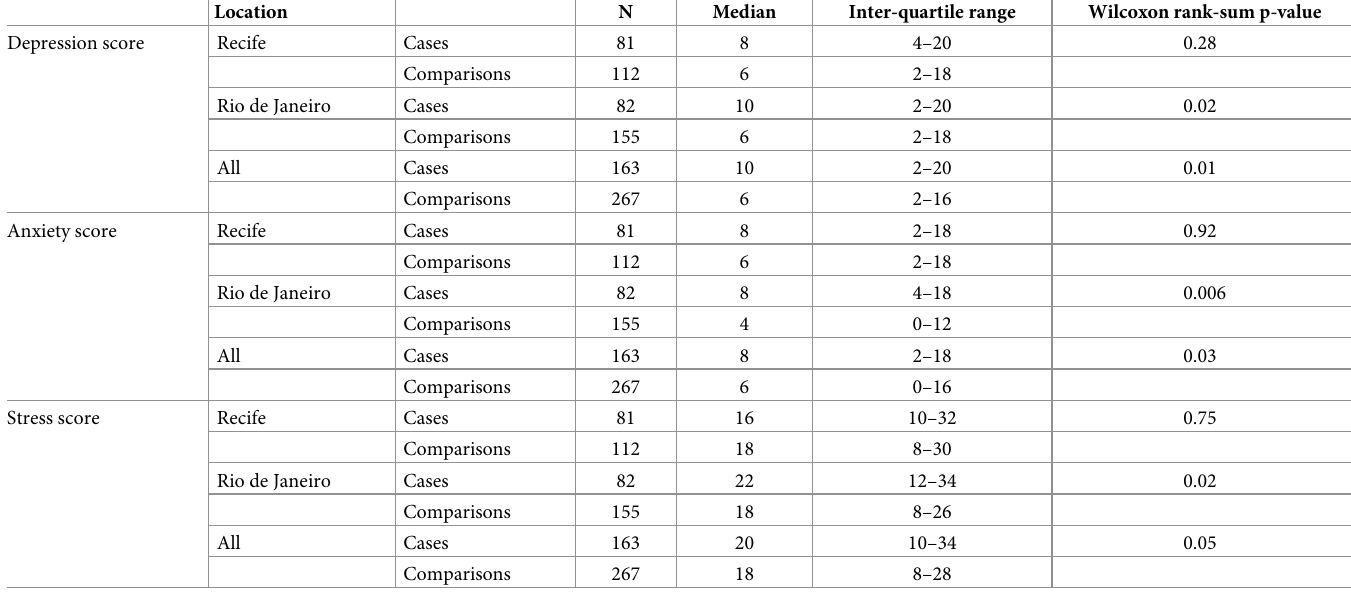
Table 2. Comparison of depression, anxiety and stress scores among cases and comparison subjects, by location.